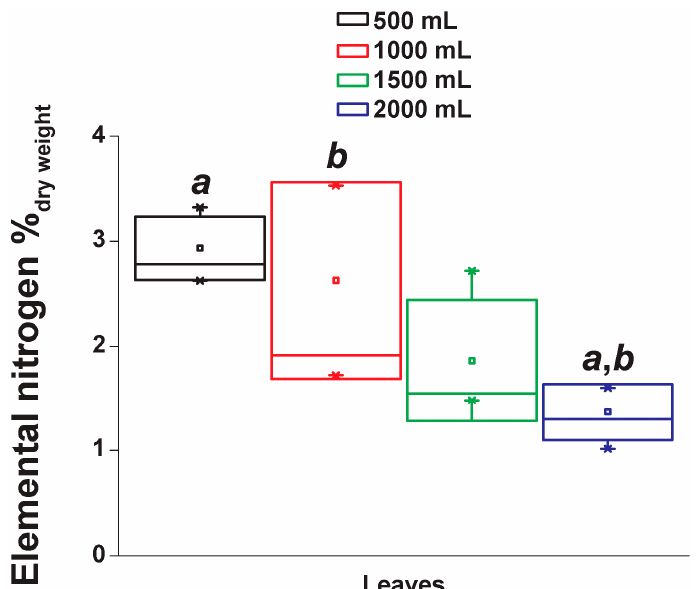
Figure 6. Leaf elemental nitrogen of Datura stramonium grown under different irrigations. Box plots show the standard deviation. Letters above bars represent significant pairwise differences according to Tukey test (ANOVA p ≤ 0.05).